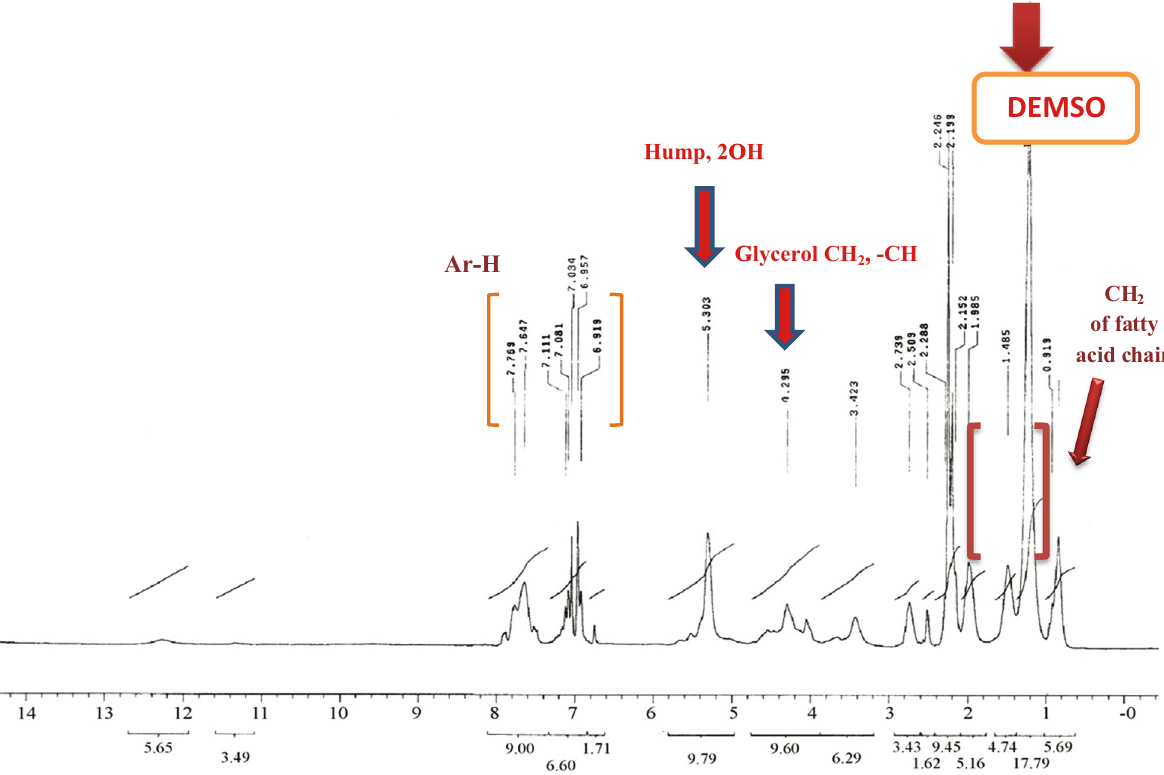
Figure 2: The H 1 NMR spectra of the prepared modi fi ed alkyd